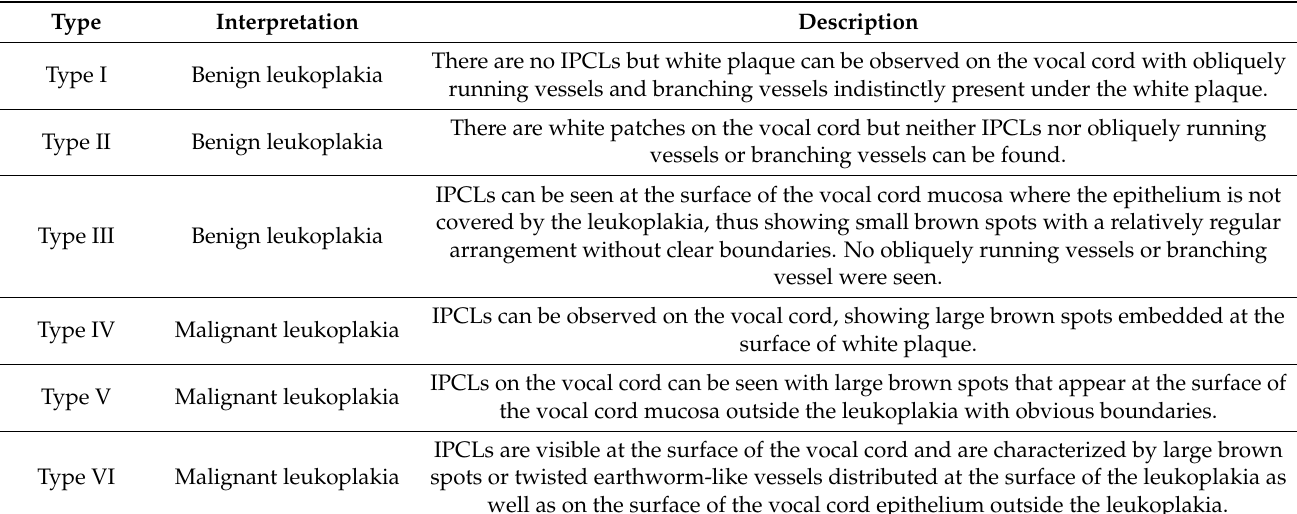
Table 7. Narrow-band imaging endoscopic classification of laryngeal leukoplakia according to Ni et al. (2019)